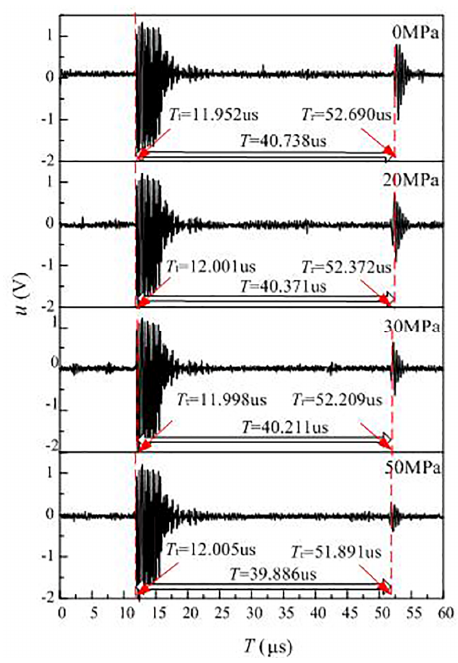
Figure 4. LCR waveforms of the specimen A under different stresses.